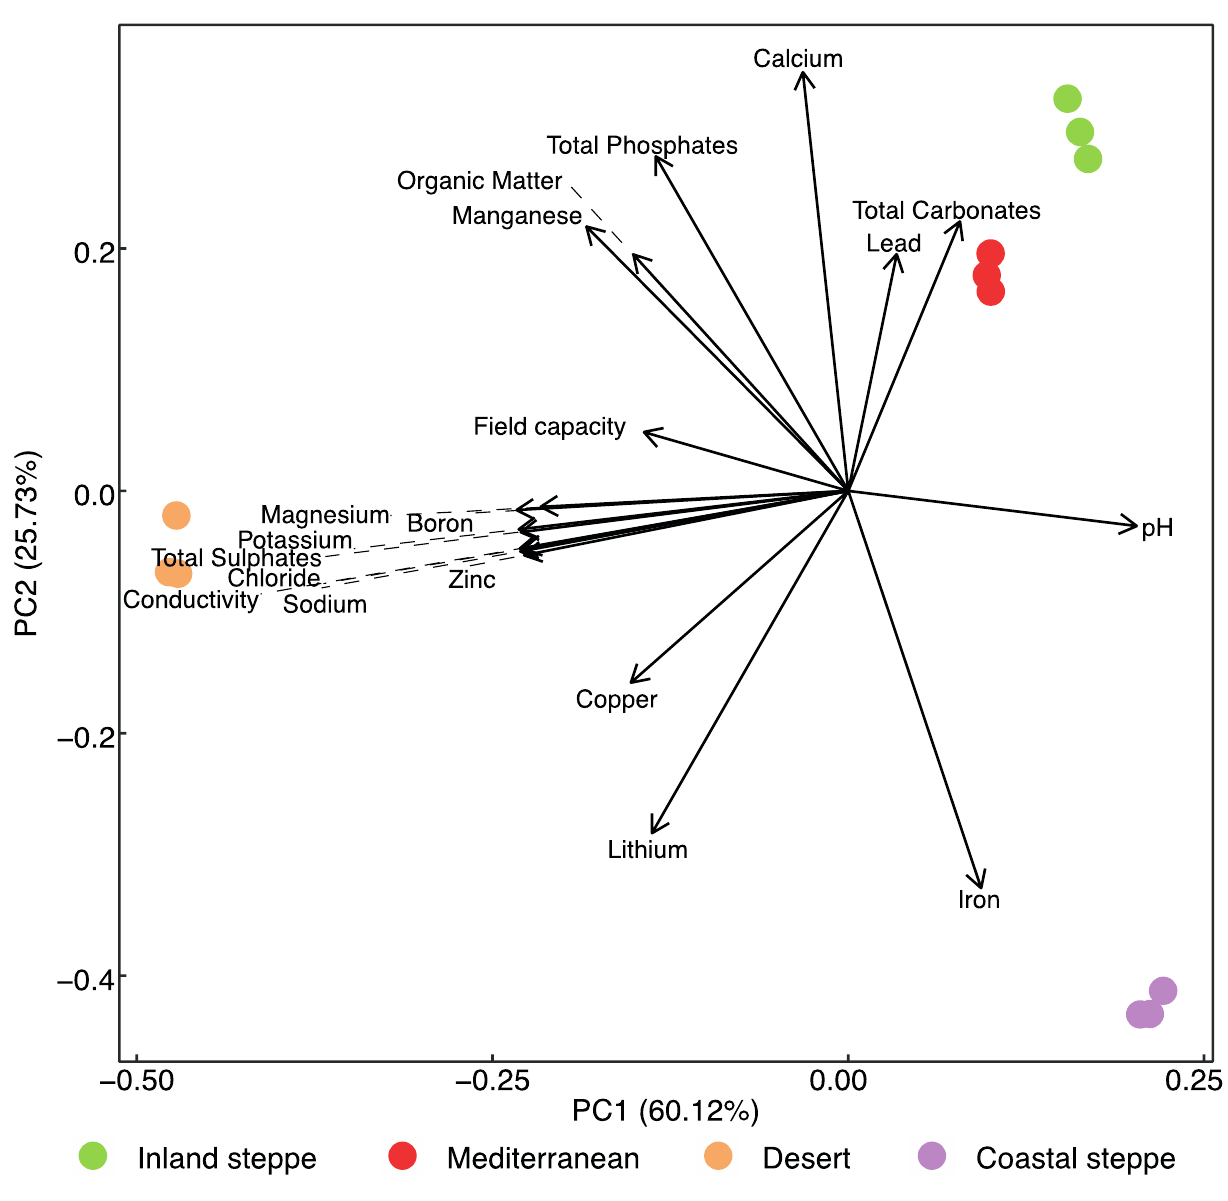
Figure 1. Principal component analysis (PCA) biplot depicting the different soils and edaphic properties. For graphical purposes, dashed lines were added to extend the vectors to connect to the corresponding labels when needed. Colored by location from Figure S1.